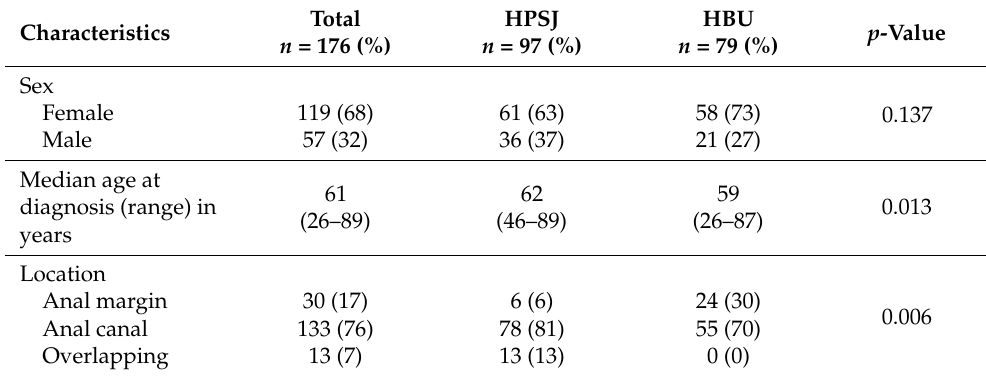
Table 1. Clinical, demographic, treatment, and follow-up data by cohort.